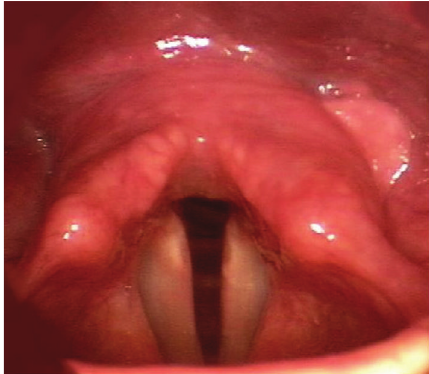
Figure 3: Video stroboscopy image of the postcricoid region 22 months after microexcision of SFT demonstrating no recurrence of